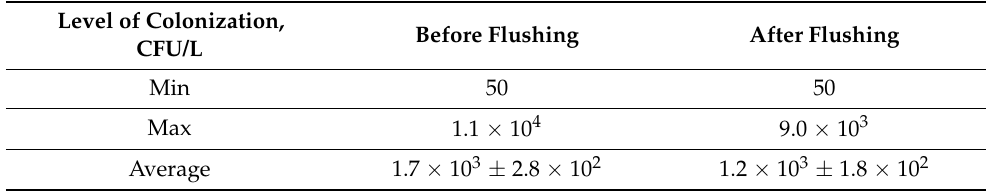
Table 4. Level of L. pneumophila colonization before and after